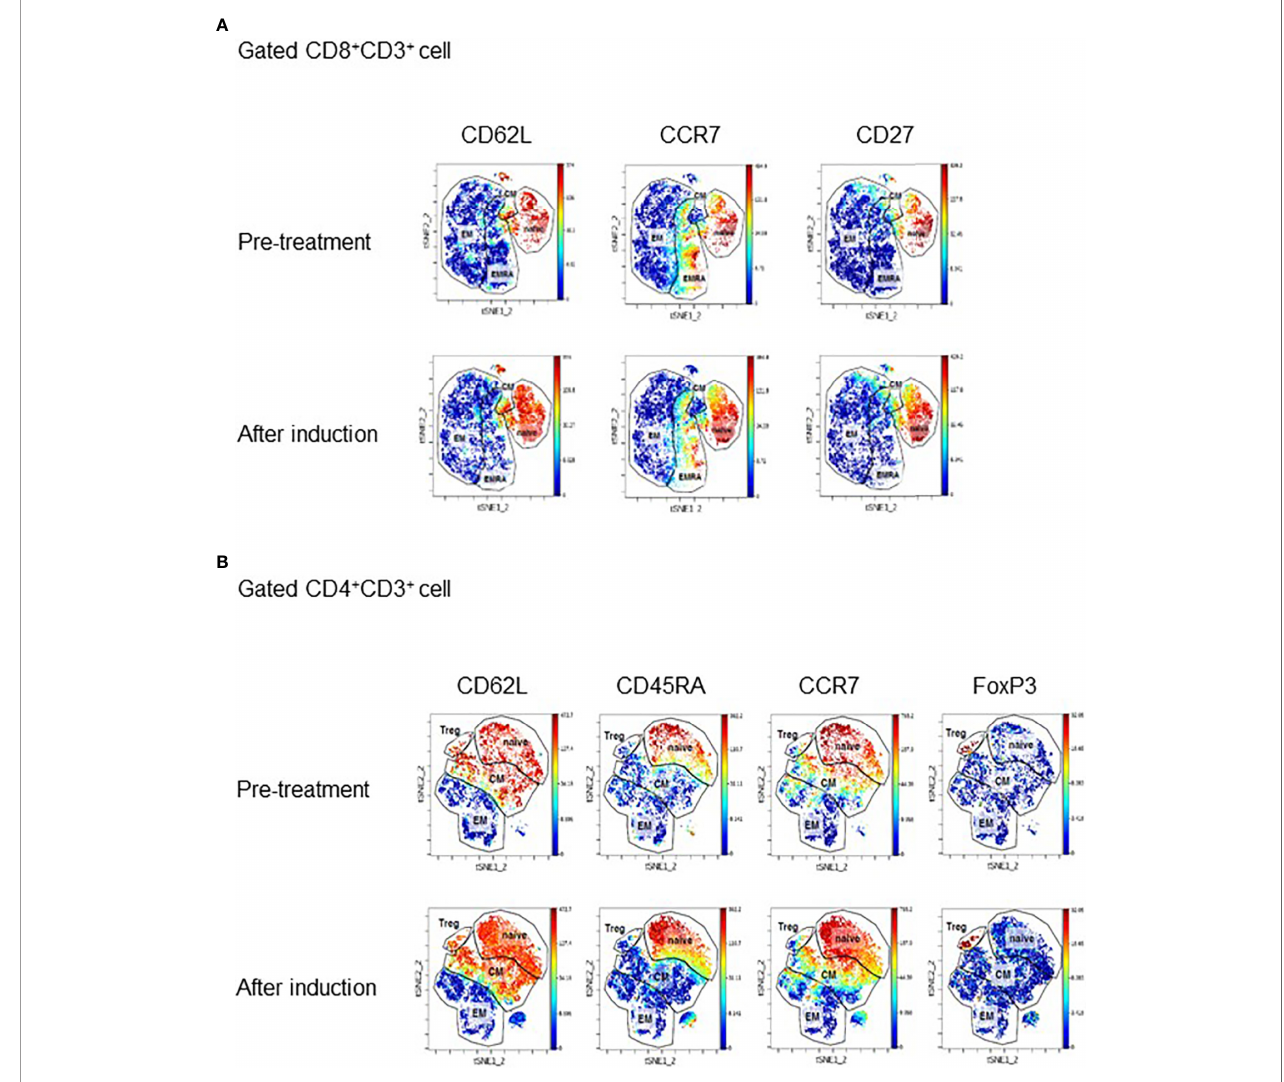
FIGURE 2 | (A) Mass cytometry data showing changes in expression of CD62L, CCR7, and CD27 in CD8 + and CD4 + T cells. The data are visualized using the t- distributed stochastic neighbor embedding (t-SNE) technique. PBMC samples were collected before ICI treatment and after induction. (B) tSNE plot displaying subpopulations of CD8 + cells (A) and CD4 + cells (B) determined by mass cytometry before treatment and after induction therapy when tumor is responding to therapy. Major subpopulations are surrounded by lines. EM, effector memory; CM, central memory; EMRA, effector memory cells re-expressing CD45RA; Treg, regulatory T